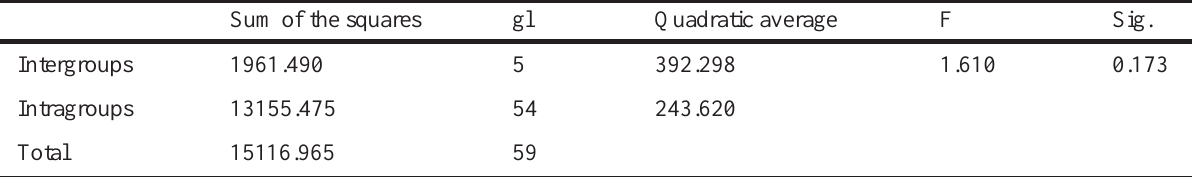
Sum of the squares